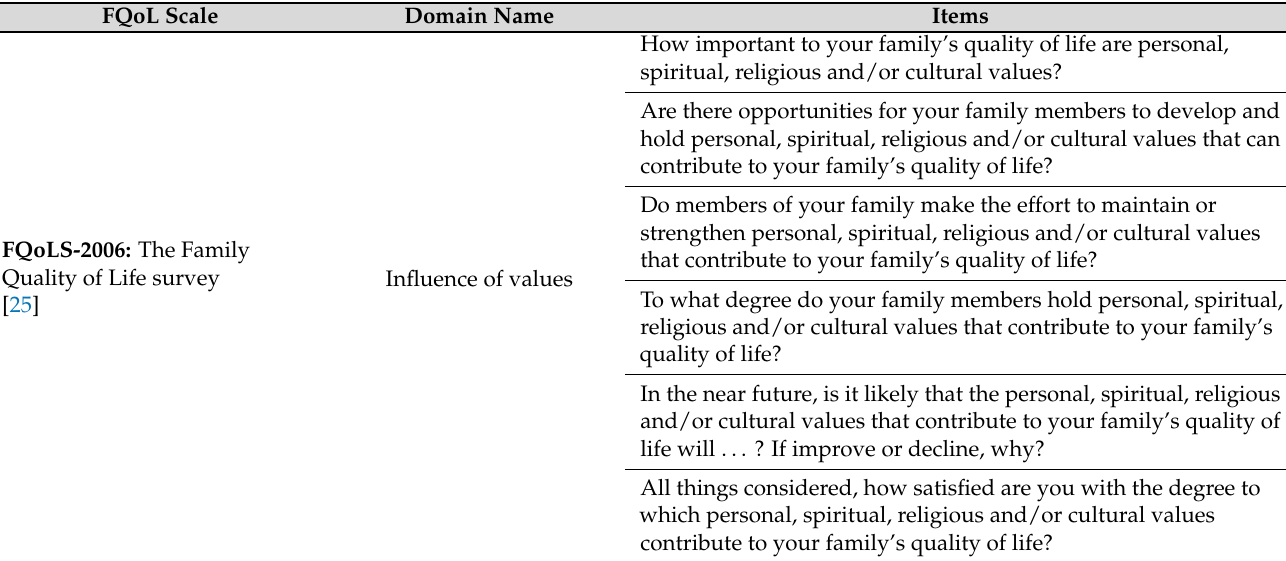
Table 11. Items considered in the domain of influence of values within each FQoL